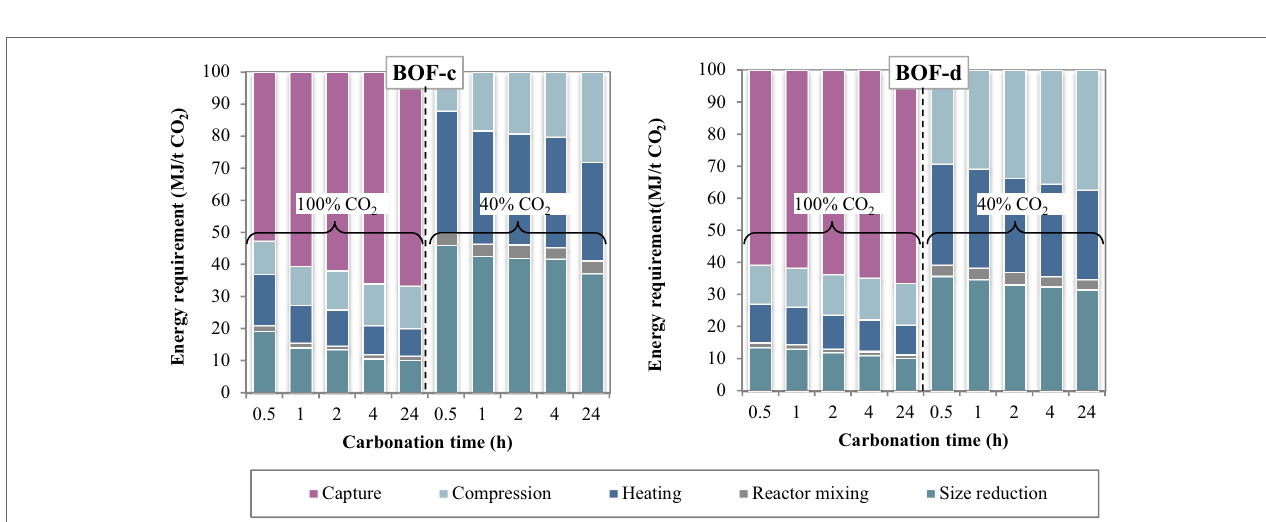
FigUre 6 | relative contribution of each unit operation to the total energy consumption as a function of the carbonation conditions (thin-film route) .